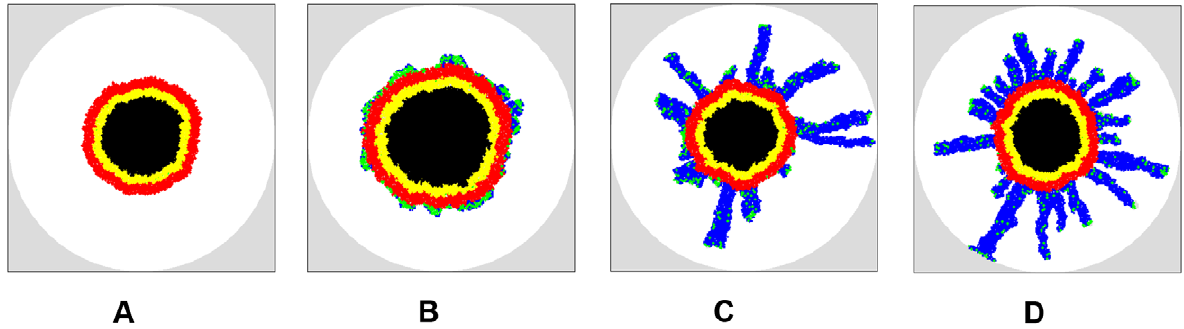
Figure 7. Simulated growing tumors in homogeneous ECM with r ECM ~ 0 : 45 on day 100 after initiation. For the invasive growth, the mutation rate is c ~ 0 : 05 and ECM degradation ability is x ~ 0 : 9 , (a) Tumor cells are noninvasive, i.e., c ~ 0 . (b) Invasive tumor with cellular motility m ~ 1 . (c) Invasive tumor with cellular motility m ~ 2 . (d) Invasive tumor with cellular motility m ~ 3 . Note that the size of the primary tumor whose growth is facilitated by the concentric-like shell formed by clumpped invasive cells (b) is much larger than the other cases. Invasive cells with a larger motility lead to more dendritic invasive branches. Although we only consider spherical growth-permitting regions here, our tumor-growth simulations can incorporate growth-permitting regions with arbitrary